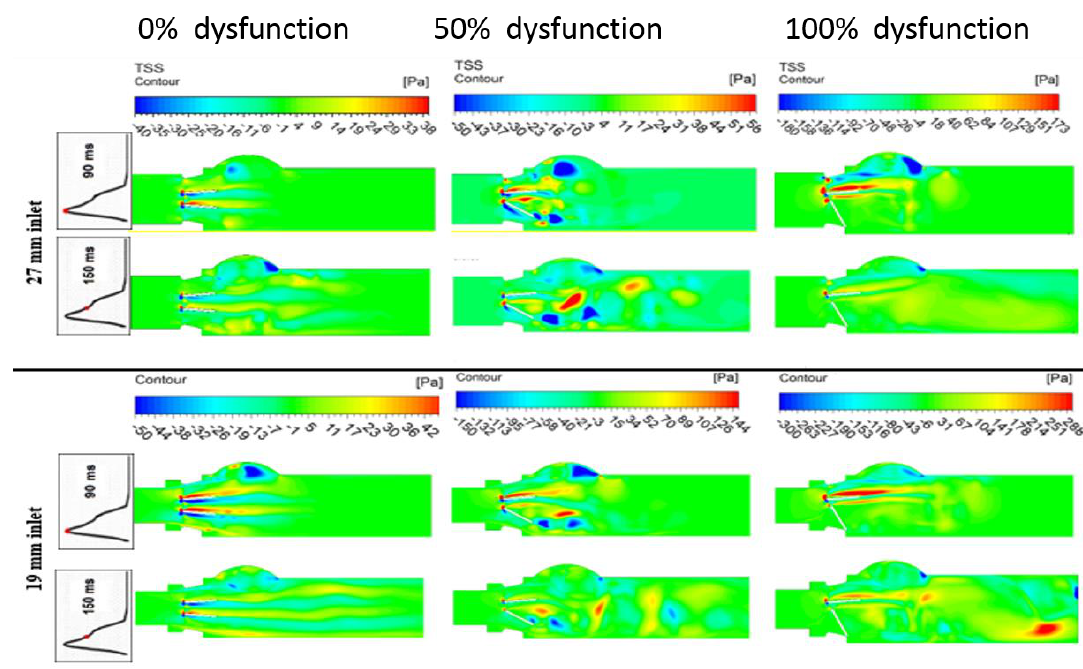
Figure 8. Shear stress magnitude contours of a healthy and dysfunction heart valve for both 27 mm and 19 mm inlet diameter at Q = 7 L/min and two time instances: peak time (90 ms) and during deceleration time (150 ms).